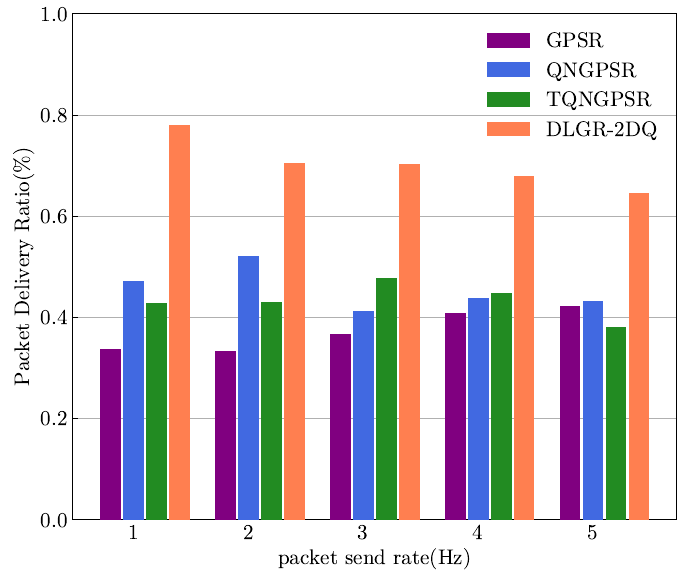
Figure 12. The effects of packet-sending rate on